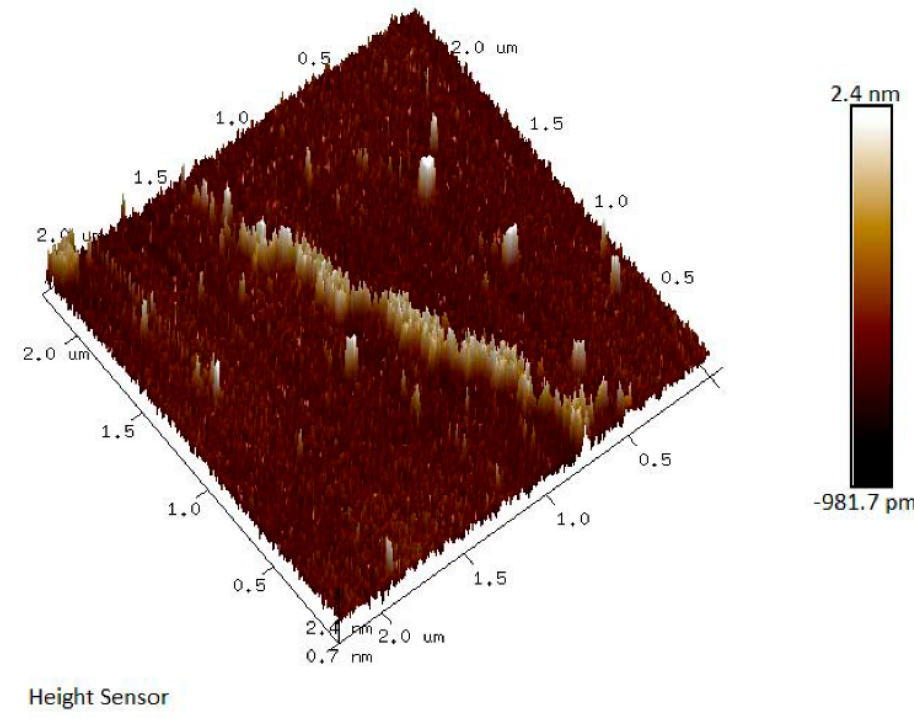
Figure 7. The AFM image of JC-PS1.